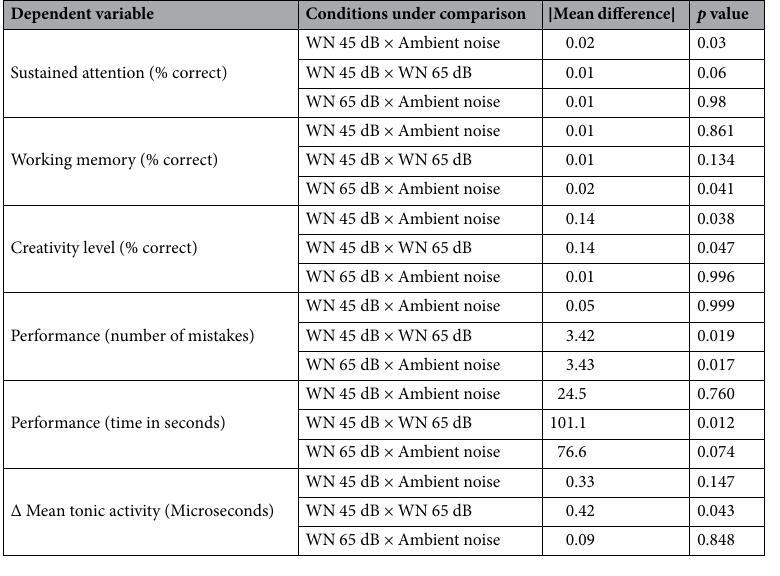
Table 2. Post Hoc analysis